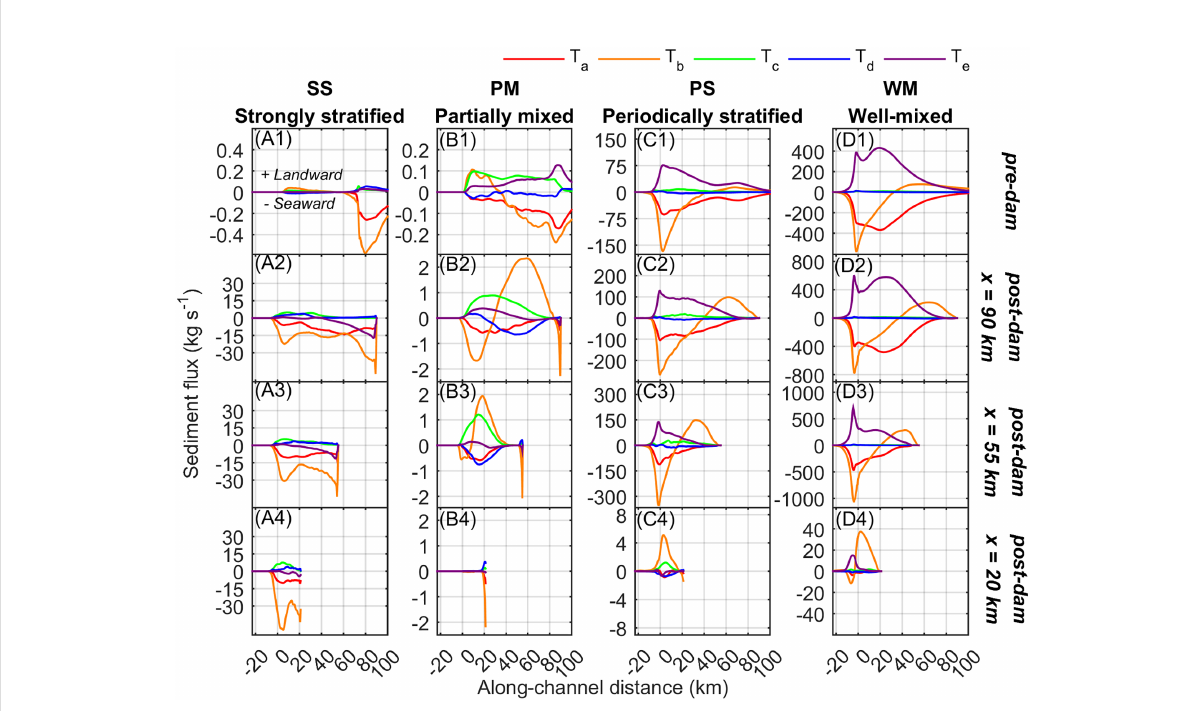
FIGURE 11 Pre- and post-dam spring-neap averaged, cross-sectionally integrated decomposed sediment fl ux (kg s -1 ) along-channel pro fi les depending on estuarine type and estuarine dam location for (A1-D1) the pre-dam estuaries, (A2-D2) dam at x = 90 km, (A3-D3) dam at x = 55 km, and (A4-D4) dam at x = 20 km for discharge interval D t = 3 days. T a is the transport by averages due river runoff or Stokes return fl ow, T b is tidal pumping, T c is estuarine exchange fl ow, T d is tidal straining, and T e is Stokes transport. Along-channel distance is distance from the estuarine mouth, positive is landward. Positive sediment fl ux is